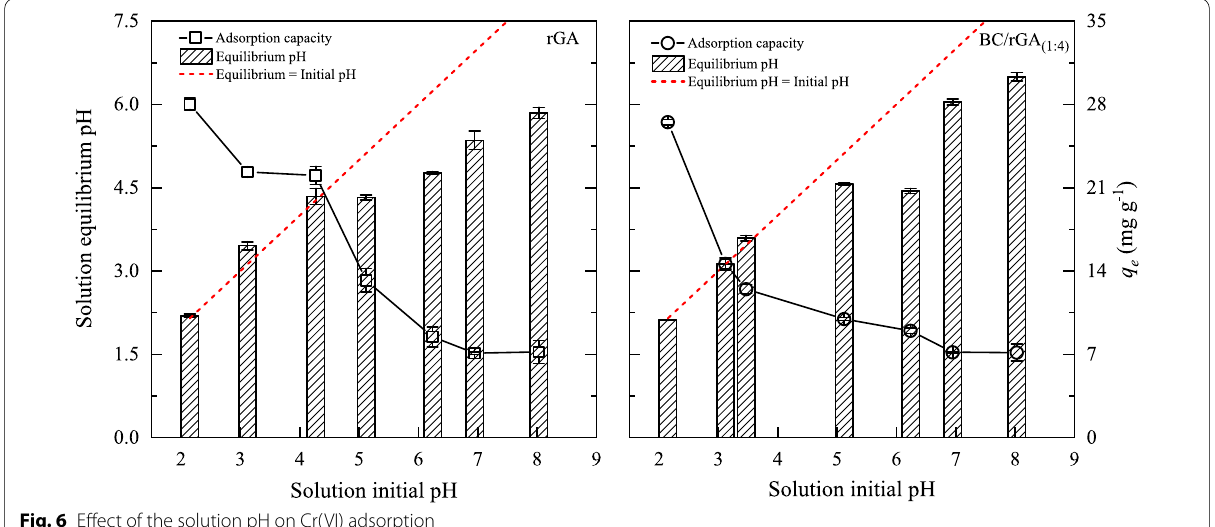
Fig. 6 Effect of the solution pH on Cr(VI) adsorption